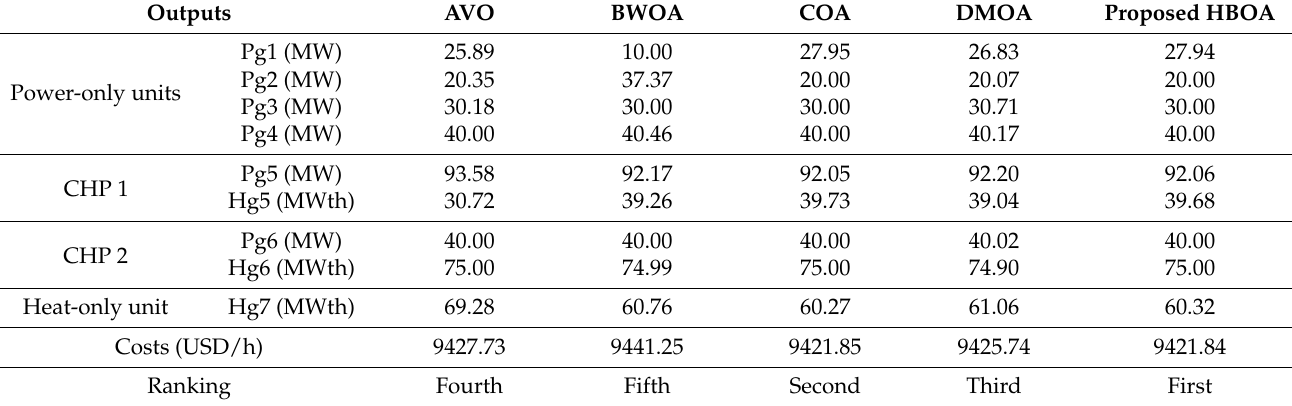
Table 4. Results of the proposed HBOA and the AVO, DMOA, COA, and BWOA of Case 1 for the second loading level.